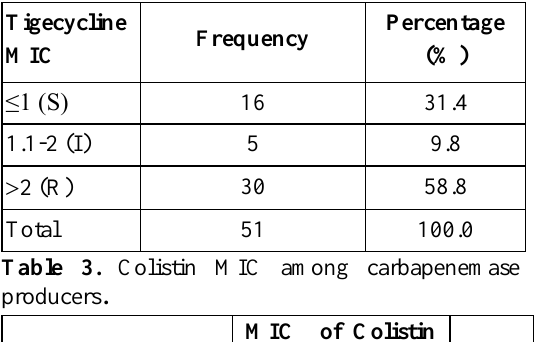
Table 5. Tigecycline sensitivity pattern according to EUCAST guidelines.